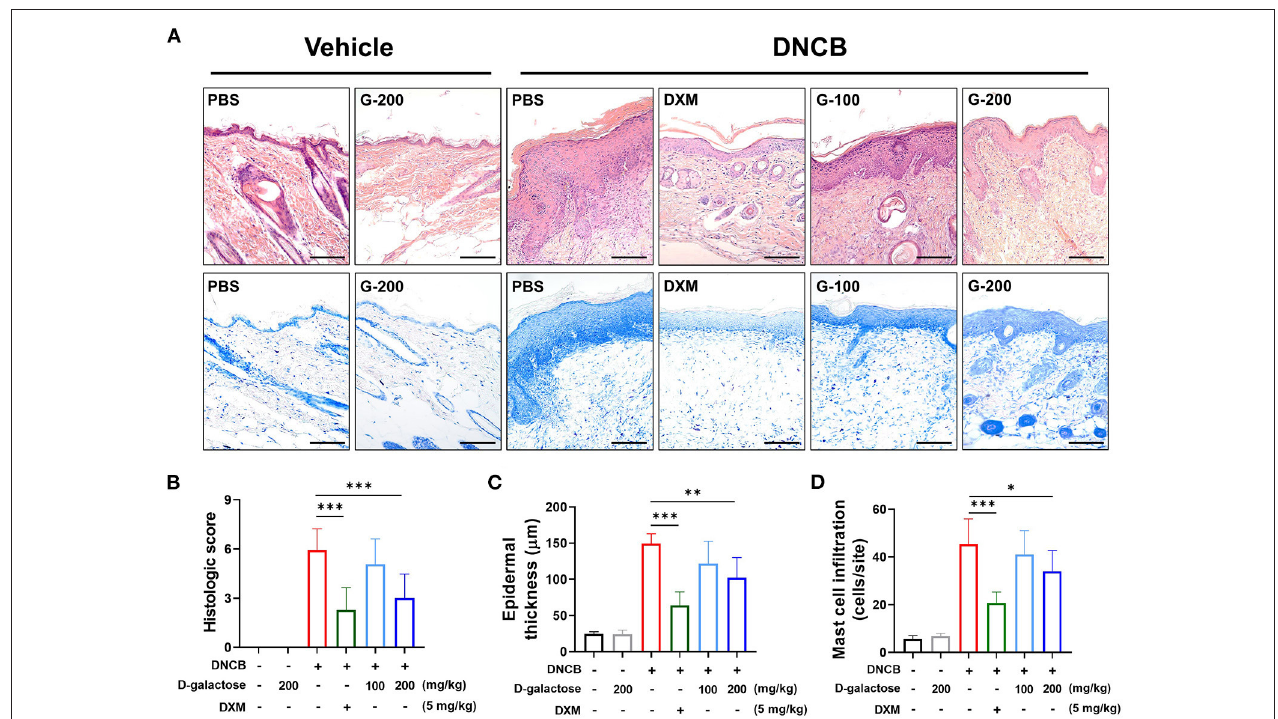
FIGURE 4 | Effect of D-galactose on cutaneous histopathological observations of DNCB-induced atopic dermatitis in mice. Representative histological findings of cutaneous tissue sections stained with (A) hematoxylin and eosin or toluidine blue staining (Scale bars, 100 µ m). Histological evaluation of (B) cutaneous tissue sections and (C) epidermal thickness. (D) Mast cell infiltration was quantified and compared among the groups. Values are means ± SD. The significance of differences between the group was assessed using Mann-Whitney U -test, with the level of significance set at * P < 0.05,** P < 0.01,*** P <